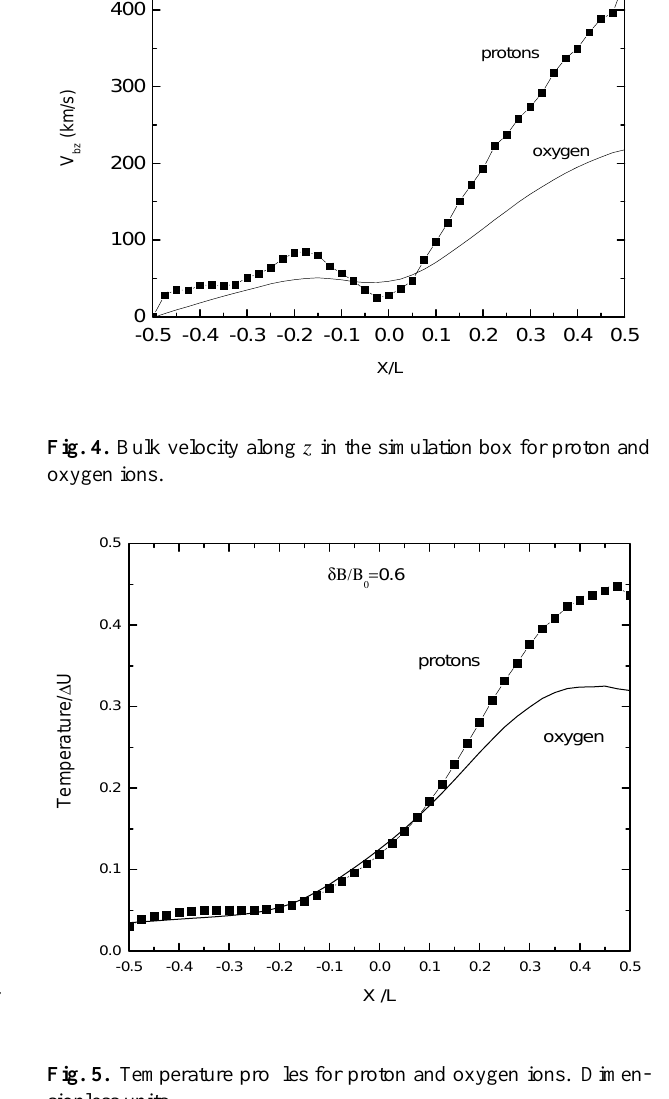
Fig. 5. Temperature profiles for proton and oxygen ions. Dimen- sionless